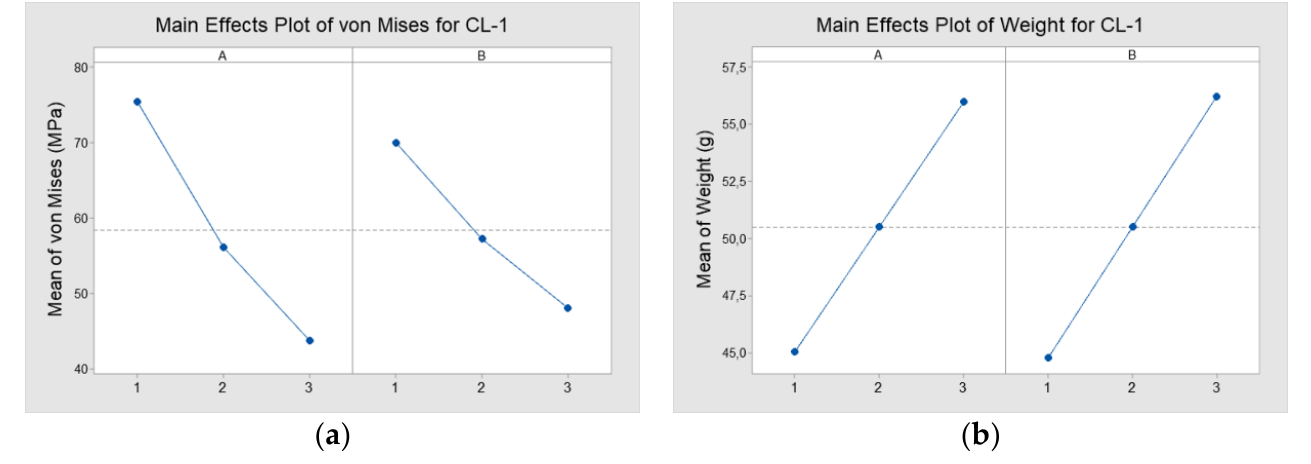
Figure 11. Study of the effect of the thickness of the first and second regions for the CN-1 structure. A and B refer, respectively, to the thickness of the first and second regions. ( a ) von Mises stress. ( b ) structure weight.